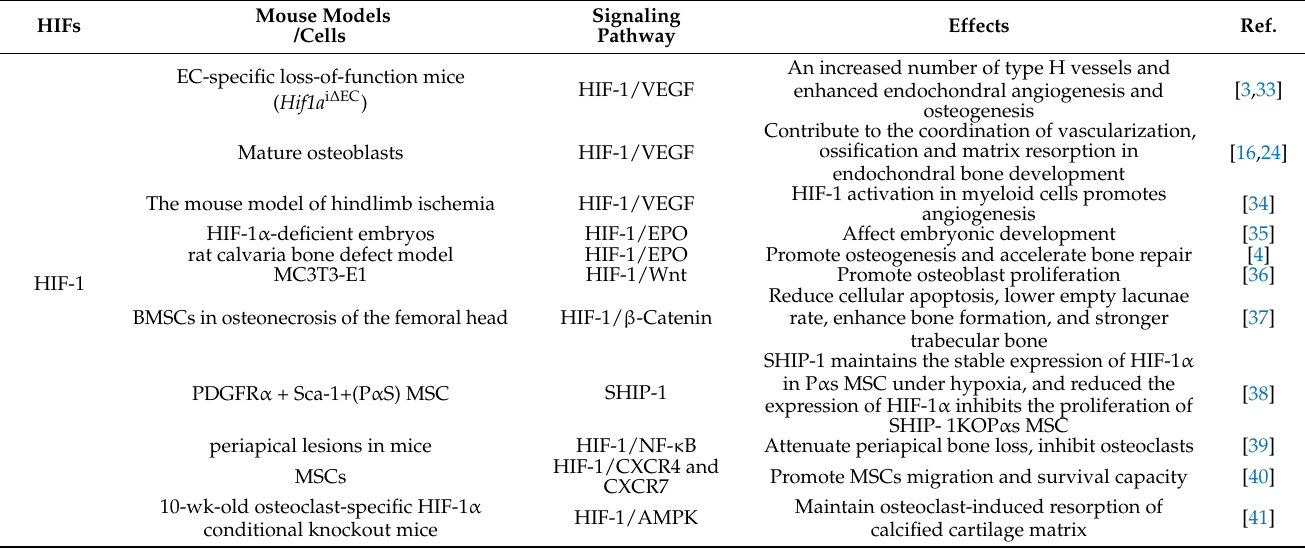
Table 1. HIF-1 functions through regulating different signals in different animal models or cells.